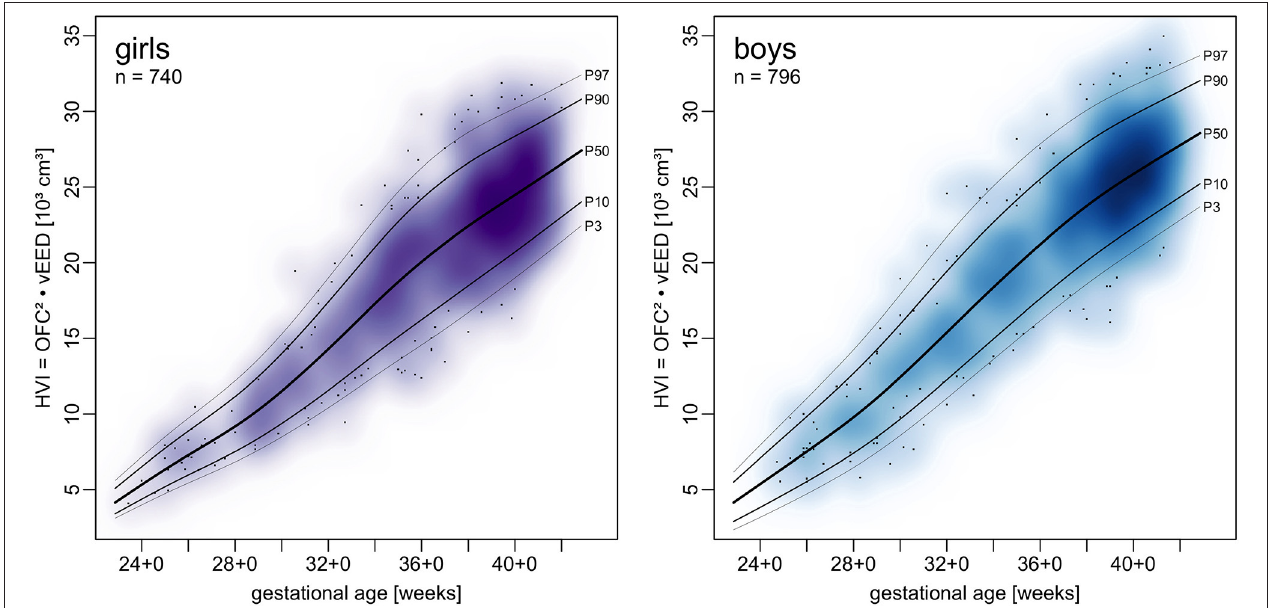
FIGURE 4 | Charts of a head volume index (HVI) combining OFC and vEED in relation to gestational